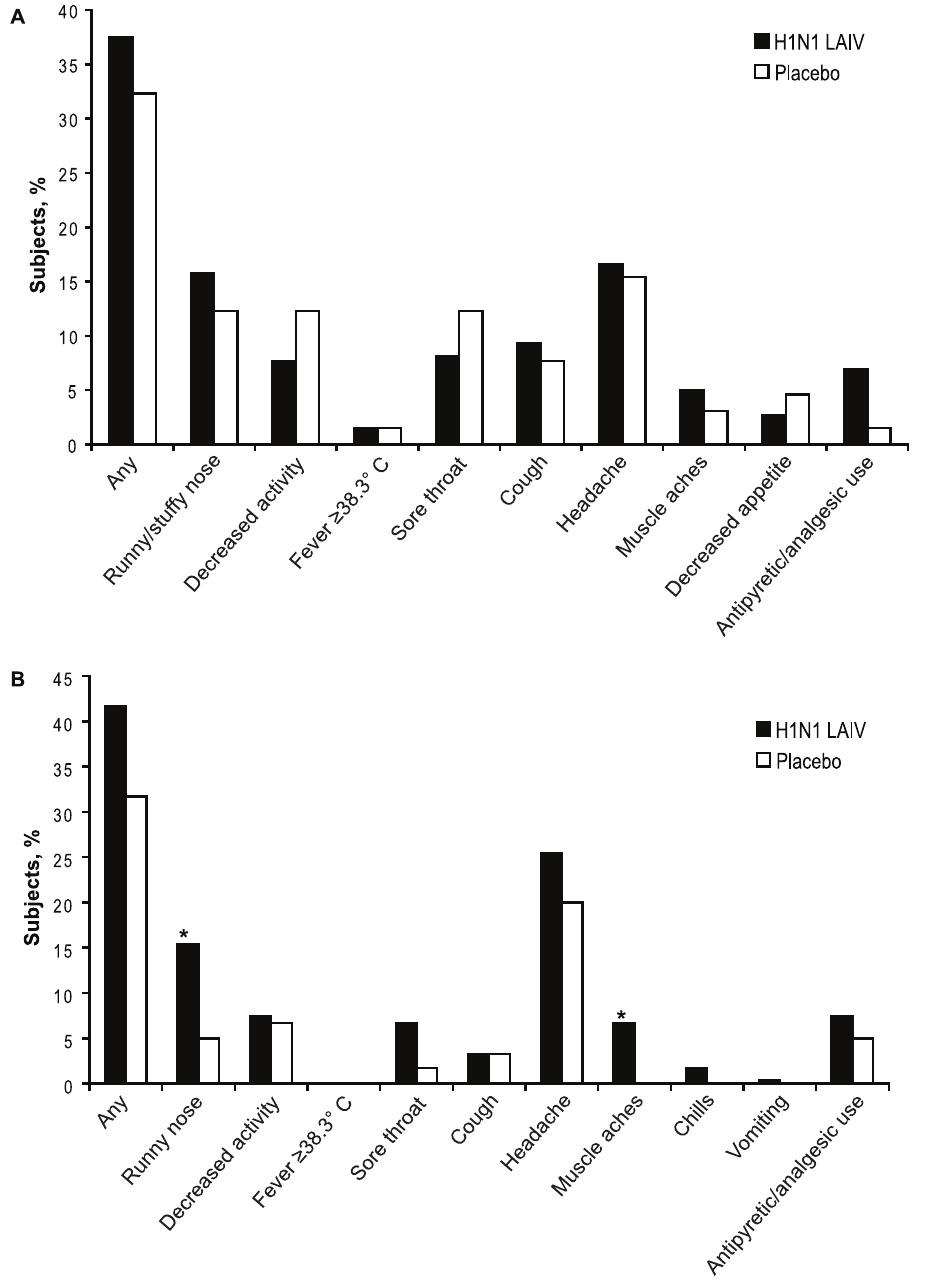
Figure 2. Solicited Symptoms in (A) Children and (B) Adults Through Day 8 Postvaccination with Dose 1. * P , 0.05.